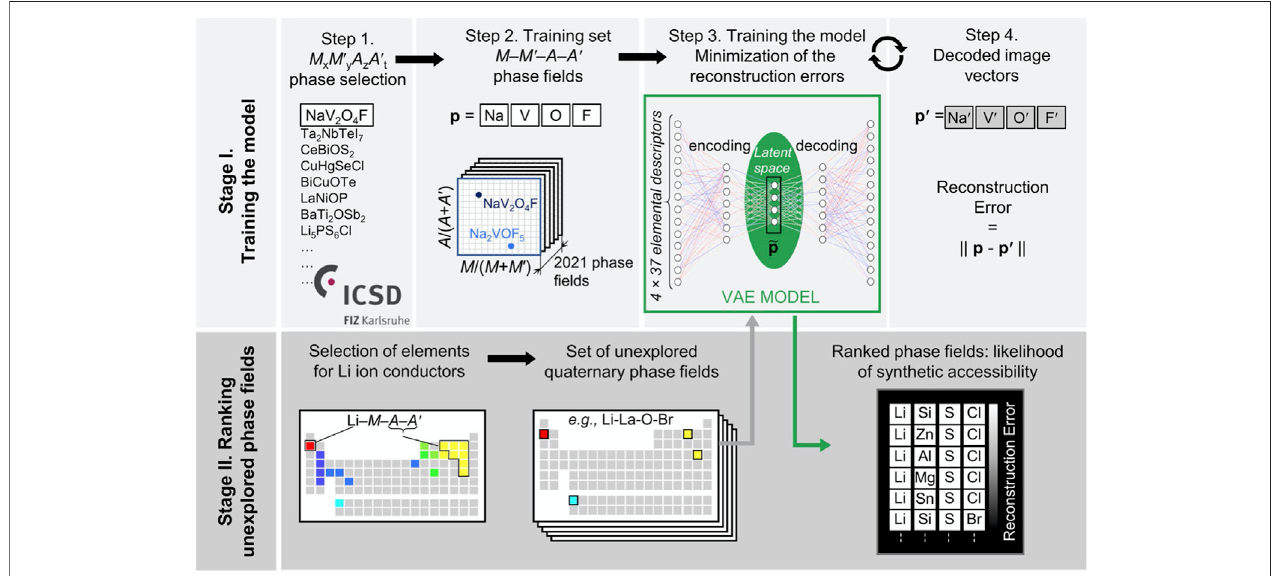
FIGURE 2 | GM approach using phase- fi elds. Stage I: Phase fi elds are gathered for two anion quartenary materials in ICSD and represented as 148-dimension (4 elements x 37 features) vector. VAE encodes/decodes each fi eld and optimizes by minimizing the reconstruction error (Euclidean distance between encoded and decoded vectors). Stage II: Exploration of new phase- fi elds for Li fast-ion conductors using the trained VAE, and corresponding ranking based on reconstruction error. Similarity of unexplored phase fi eld to explored phase fi eld dictates how ideal it is for experimental exploration. Reprinted with permission from Vasylenko et al.